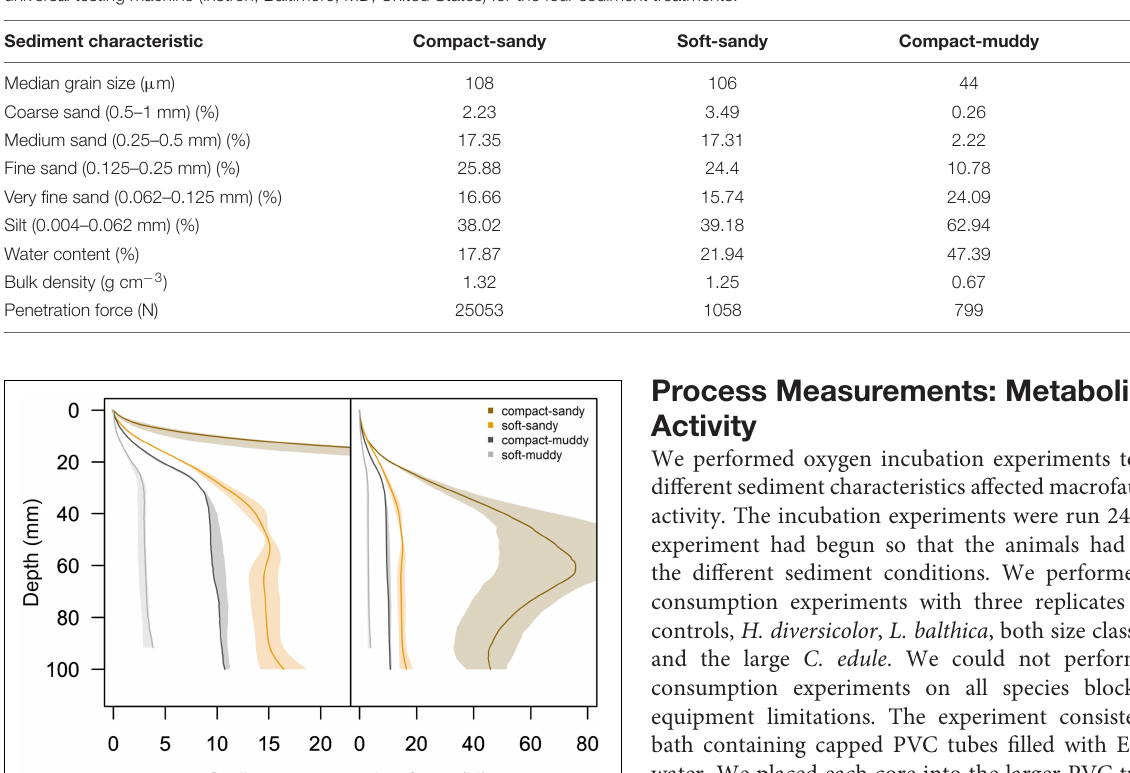
TABLE 2 | Median values for sediment characteristics (median grain size, grain size composition, water content, bulk density, penetration force as measured by a universal testing machine (Instron, Baltimore, MD, United States) for the four sediment treatments.